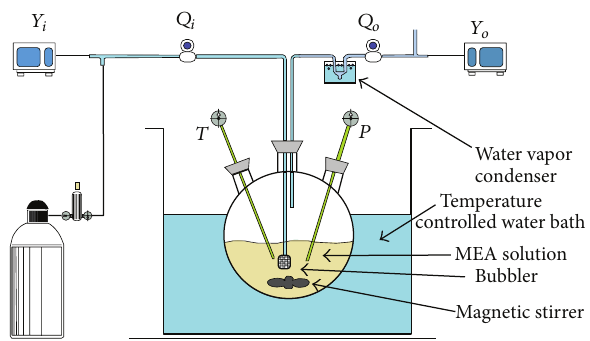
ND: not defined; FS: full scale.